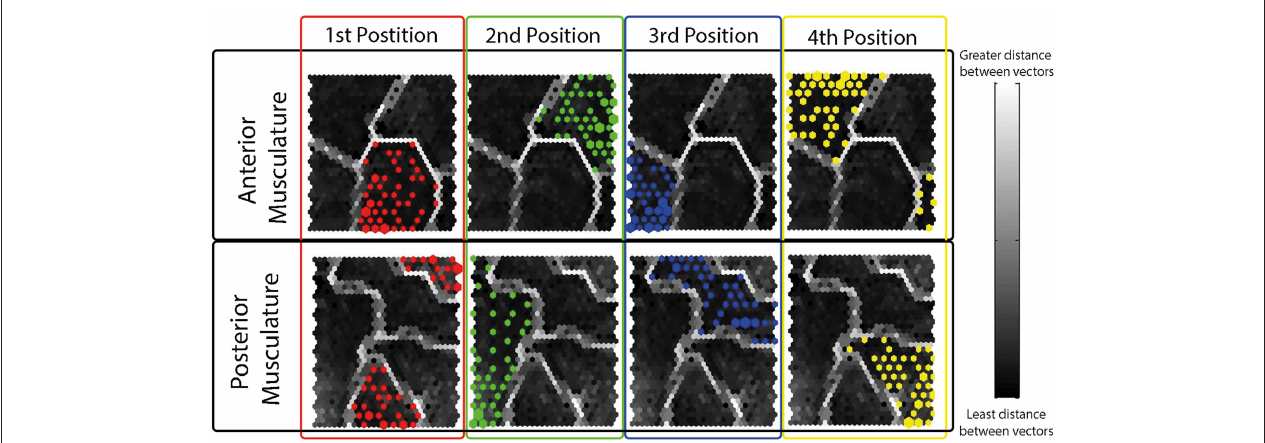
FIGURE 6 | Resulting Hit Histograms from a Randomly Selected Subject during a Typical Test- Each hit histogram is shown on the resulting topographical map after the network was trained using the 60% of the data. The four different thumb grips have been separated and color coded by electrode grid locations (anterior musculature; posterior musculature). As observed, each position has a defined area in the topographical map different to the rest of the positions showing interrelations amongst same thumb opposition tasks.